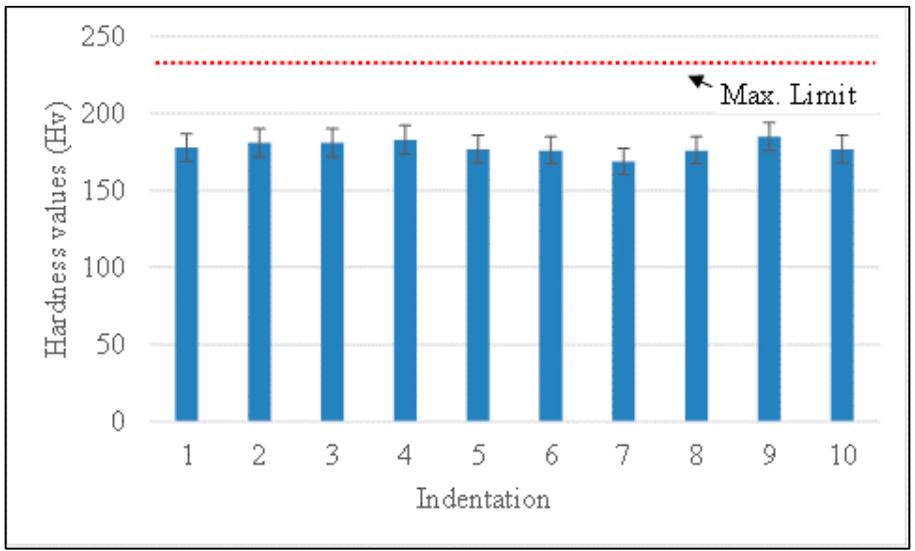
Figure 11. Hardness variations across the weldment.